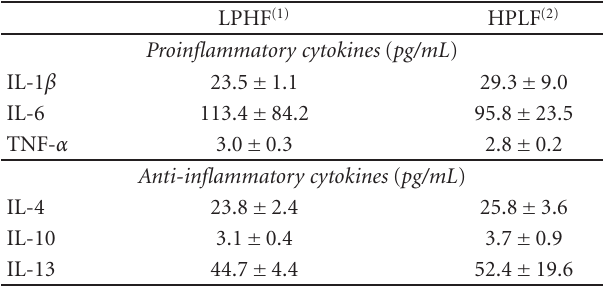
Table 2: Serum levels of inflammatory